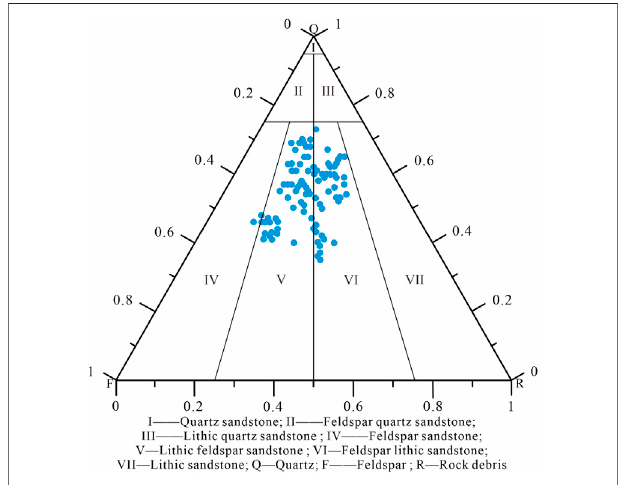
FIGURE 3 | Lithologic triangular diagram of sandstone in the Chang 3 Member in Weibei Oil fi eld.